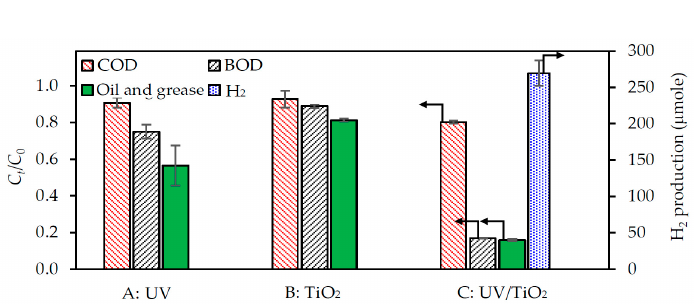
Figure 3. Comparison of pollutant removal and H 2 production of the 3.3-fold diluted acid-pretreated biodiesel wastewater after a 4-h treatment with ( A ) UV light at an intensity of 4.79 mW/cm 2 ; ( B ) photocatalyst at 4.0 g/L and ( C ) UV/TiO 2 at a dosage of 4.0 g/L and UV light intensity